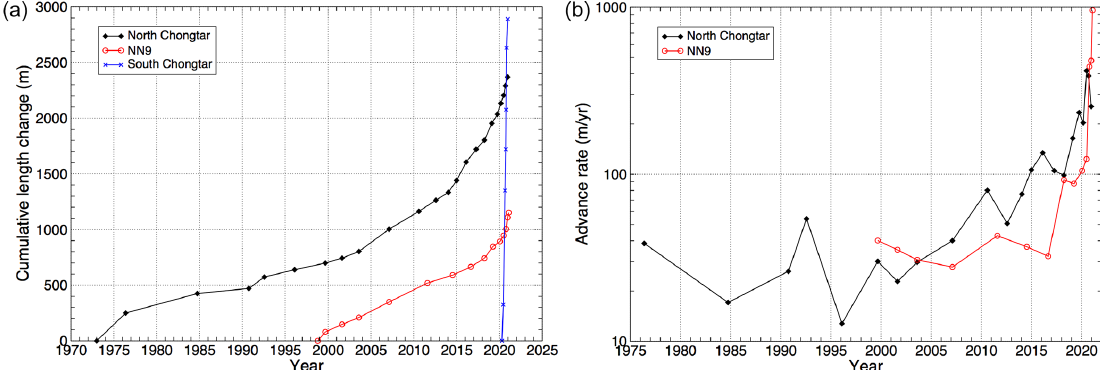
Figure 4. Terminus changes for the investigated glaciers. (a) Cumulative length changes (the retreat phase of South Chongtar before 2020 is not shown), (b) advance